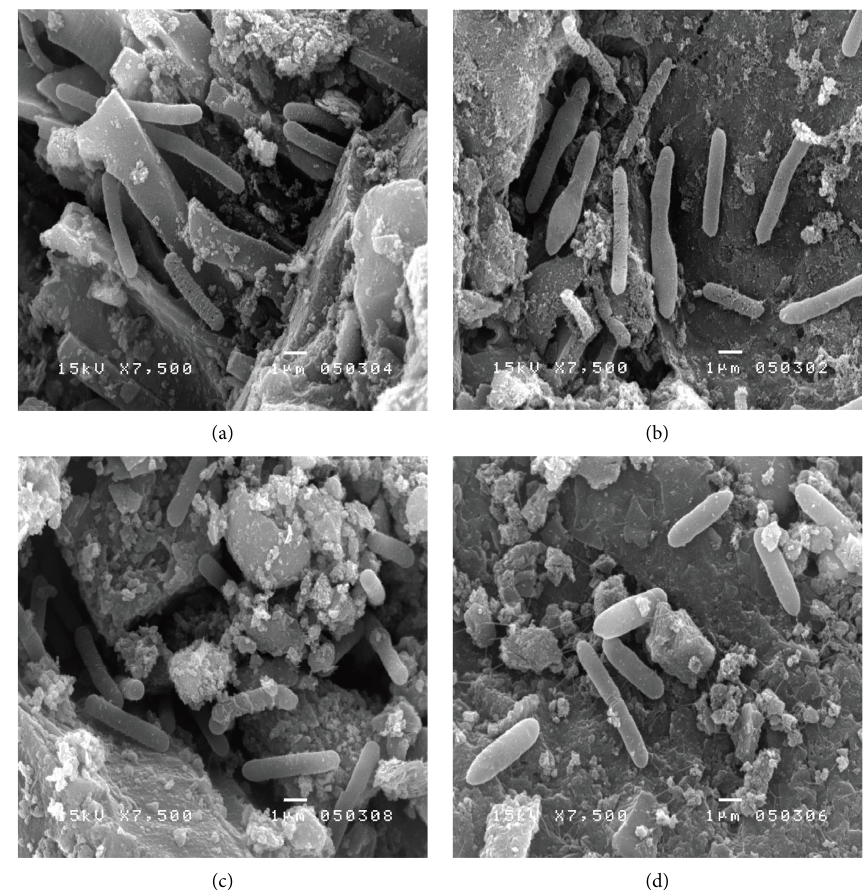
Figure 7: Representative SEM images (7500x magnifcation) of (a) SH S , (b) NASH S , (c) SH R , and (d) APTES R after 120h of batch fermentation showing the colonization of C. beijerinckii . Images shown are representative of those seen from at least three such felds of view and three independent